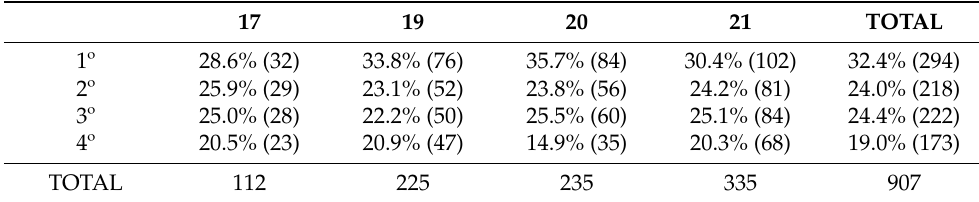
Table 1. Birth distribution according to trimester.